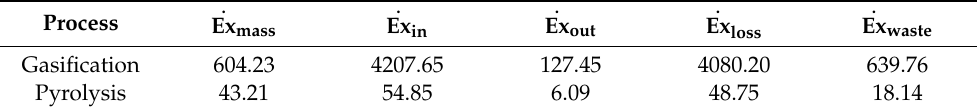
Table 5. Exergy analysis results for gasification and pyrolysis